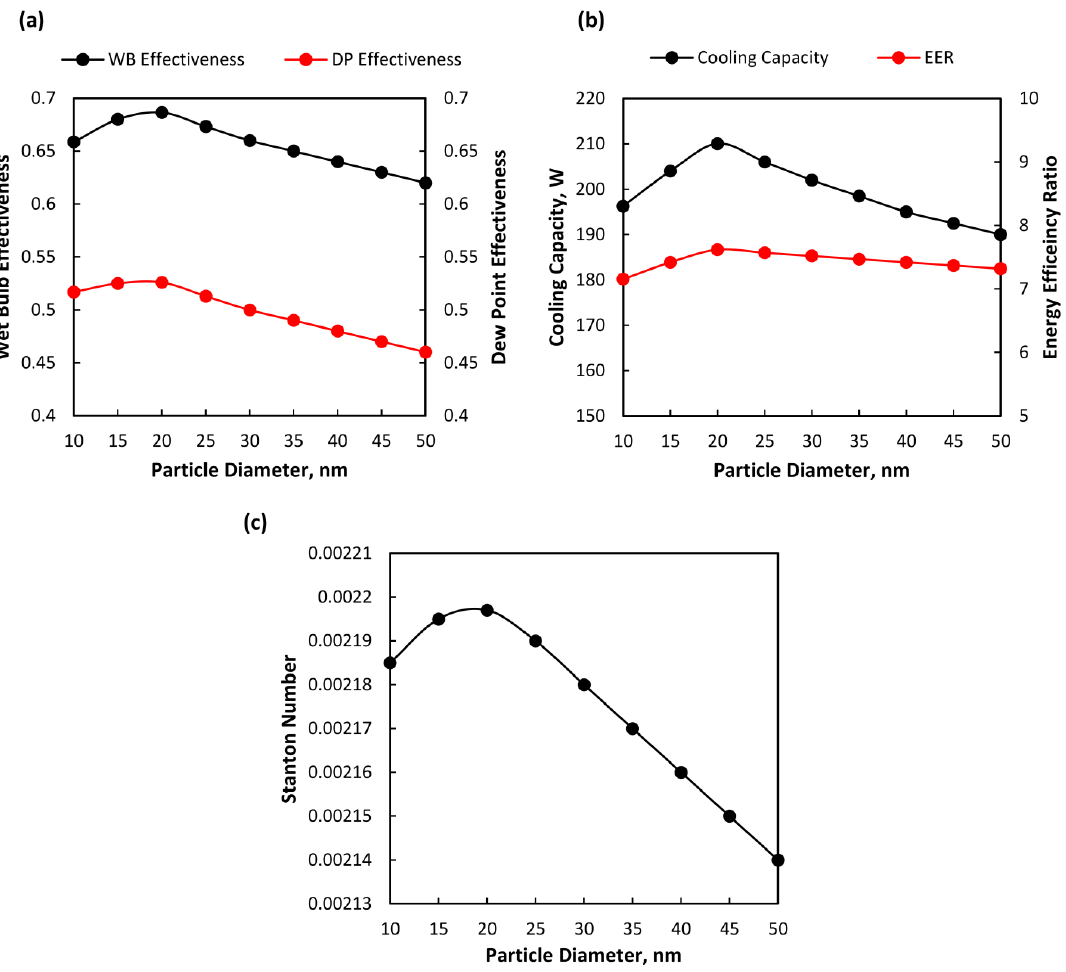
Figure 10. Influence of particle diameter on ( a ) wet bulb (WB), dew point (DP) cooling effectiveness; ( b ) cooling capacity, Energy Efficiency Ratio (EER); and ( c ) Stanton number.